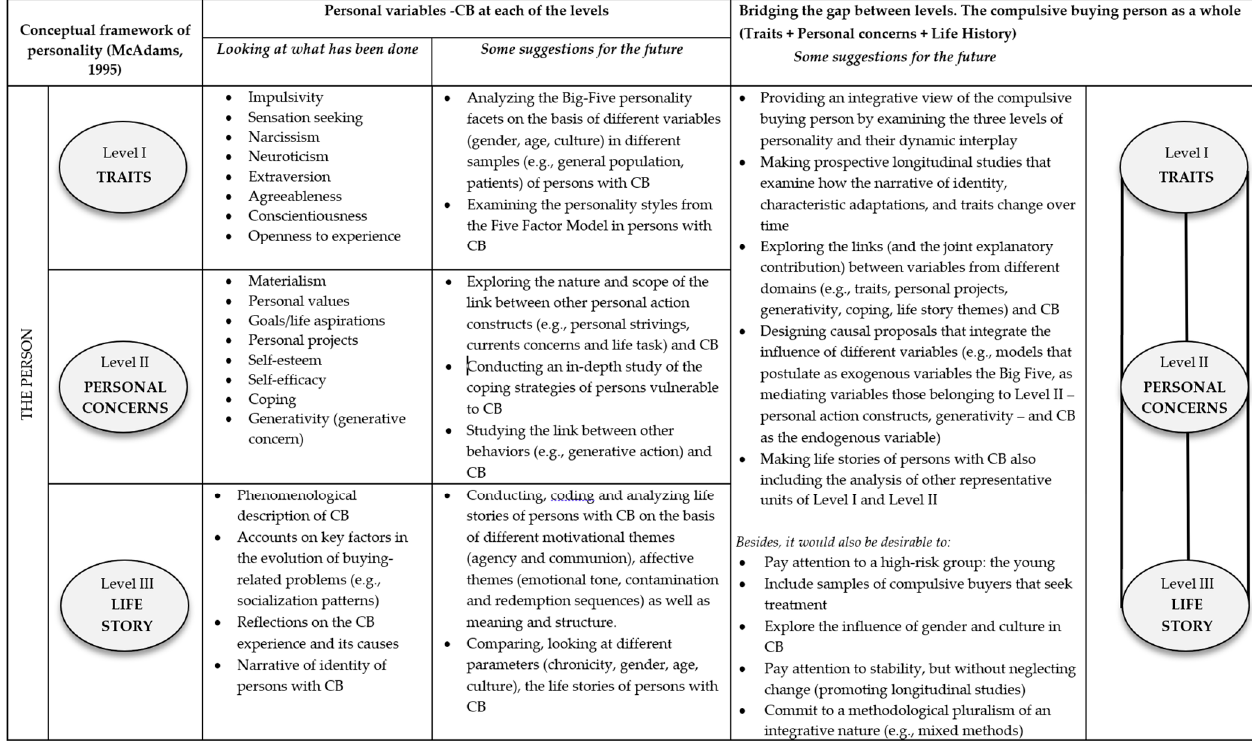
Figure 1. Evidence available with regard to the personal variables and compulsive buying in the light of the conceptual framework of personality by McAdams (1995) along with some integrative suggestions for the future in connection to the different levels of analysis (traits, personal concerns, life story) to study a person who is a compulsive buyer.